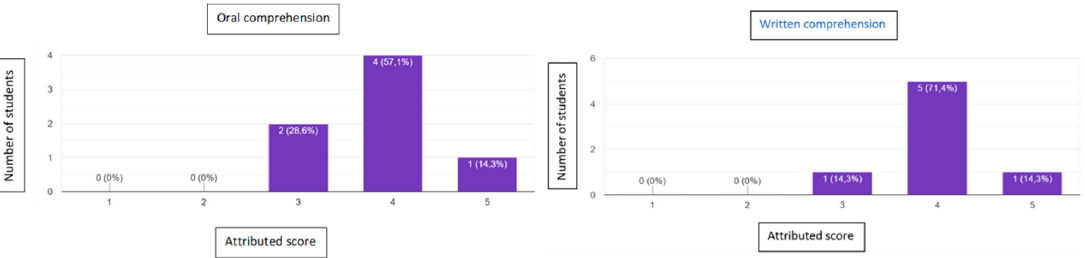
Figure 4. Comprehension competences chart of F3/F6 students.